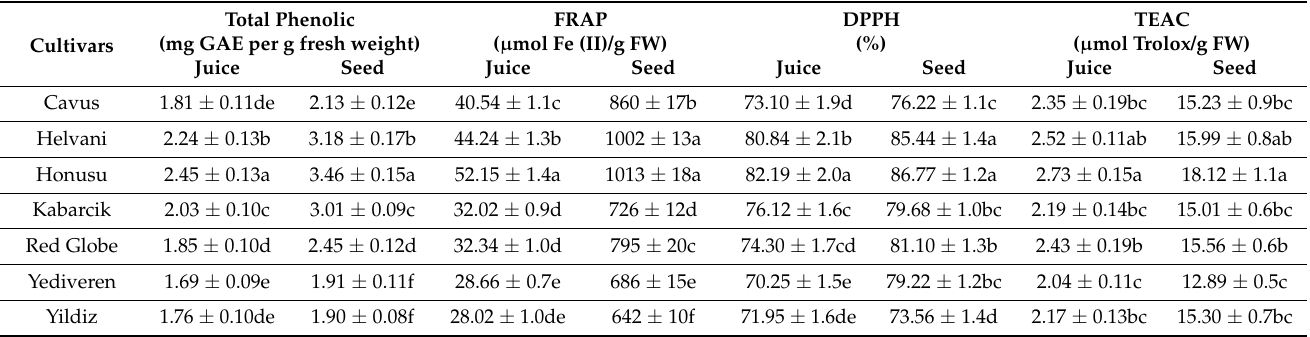
Table 2. Total phenolic content and antioxidant activity of grape juices and